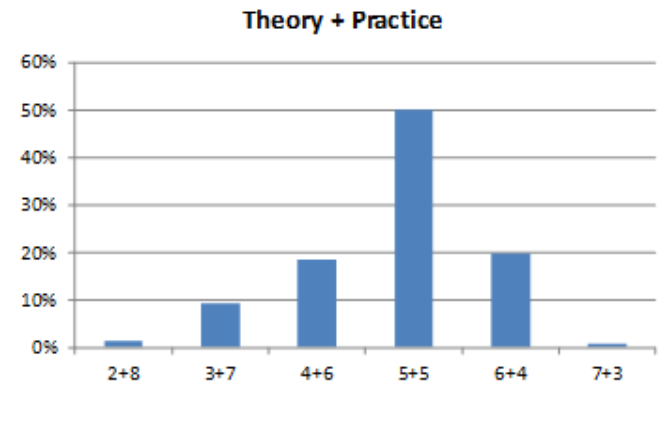
Figure 3. Weight of the theory/practice